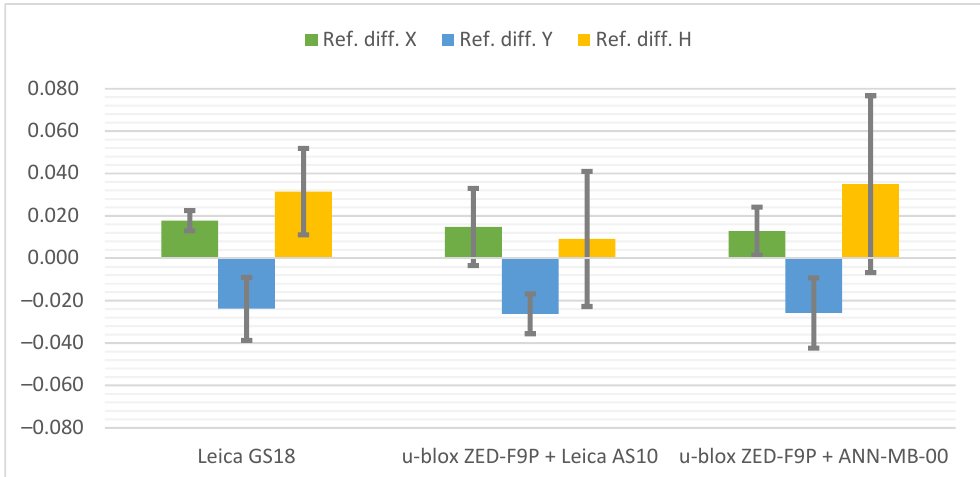
Figure 10. Cumulated diagrams with results of measurements at the Pt 5 station (obscured horizon from the west and the top; differences in relation to the reference points with standard deviations [m]).